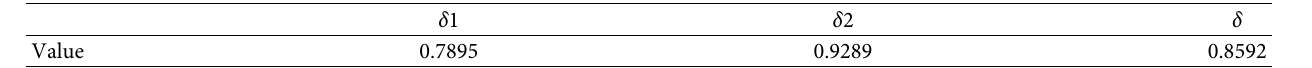
Table 17: .e consensus threshold without considering the adjustment willingness.